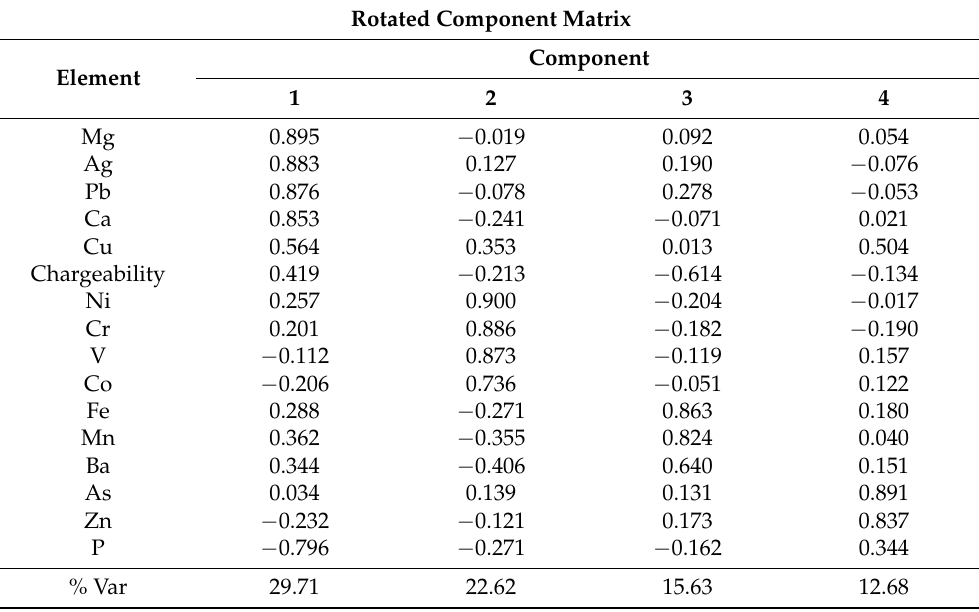
Figure 6. Rotation of PCs using the varimax procedure. Table 4. Results obtained for the PCA. The solutions rotated by the varimax method with Kaiser normalization are shown. % Var: percentage of variance for each